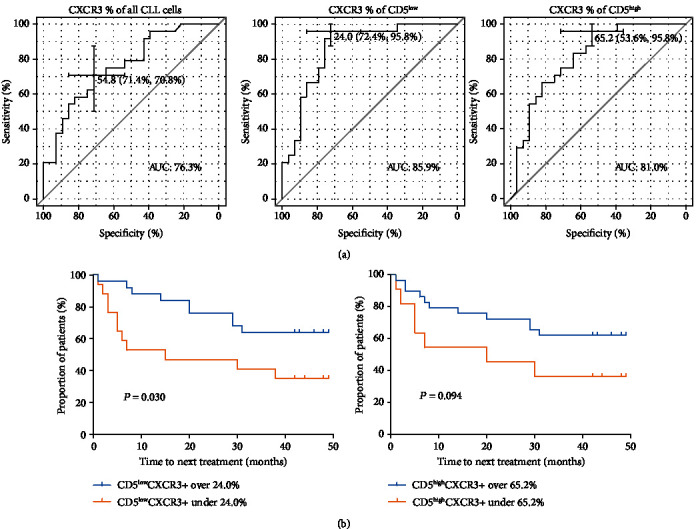
(a) Receiver operating characteristic (ROC) curves created for the percentage of CXCR3 positive all CLL cells, CD5low and CD5high cells, respectively, in patients with IgHVmut and IgHVunmut status. AUC: area under ROC curve. (b) Kaplan-Meier curves of time to next treatment in CLL patients according to the cut-off values of the percentage of CXCR3 on CD5low and CD5high cells.